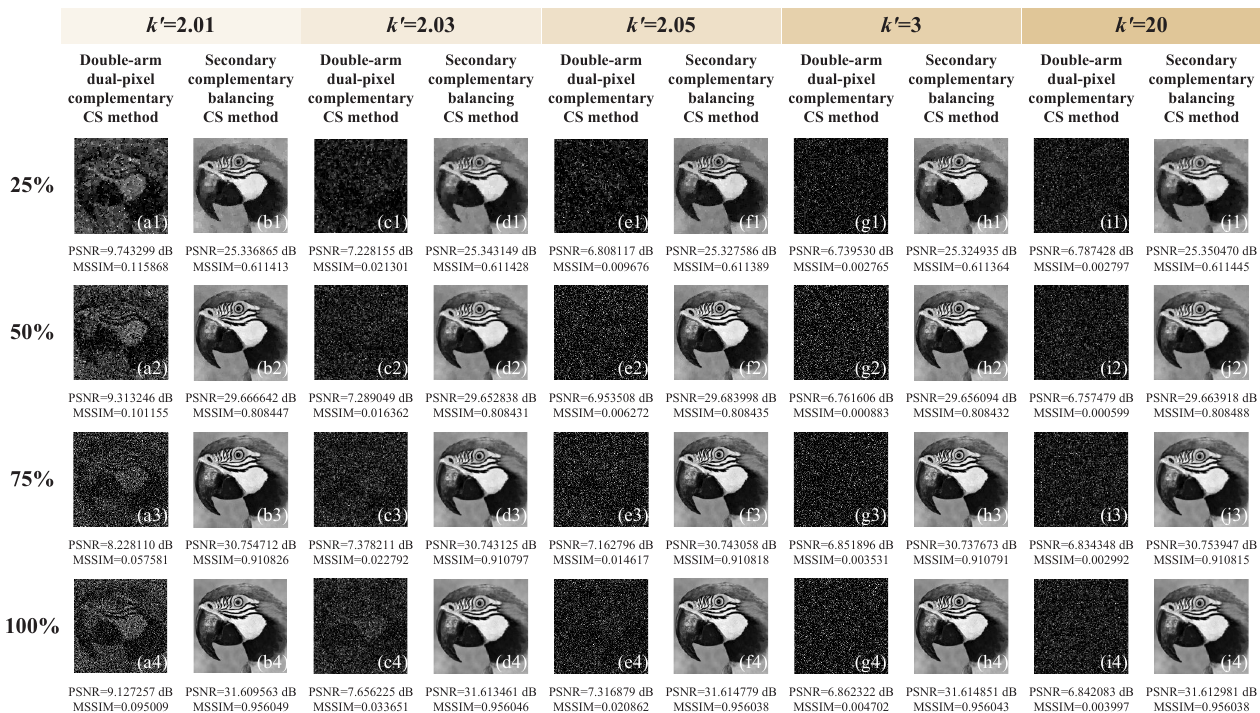
Figure 2. Simulation results of the image parrot by using traditional double-arm dual-pixel comple- mentary CS (( a1 – a4 ), ( c1 – c4 ), ( e1 – e4 ), ( g1 – g4 ) and ( i1 – i4 )) and secondary complementary balancing CS method (( b1 – b4 ), ( d1 – d4 ), ( f1 – f4 ), ( h1 – h4 ) and ( j1 – j4 )), with different sampling rates 25%, 50%, 75%, and 100% (from top to bottom ) and different imbalance coefficients k (cid:48) = 2.01, 2.03, 2.05, 3, and 20 (from left to right